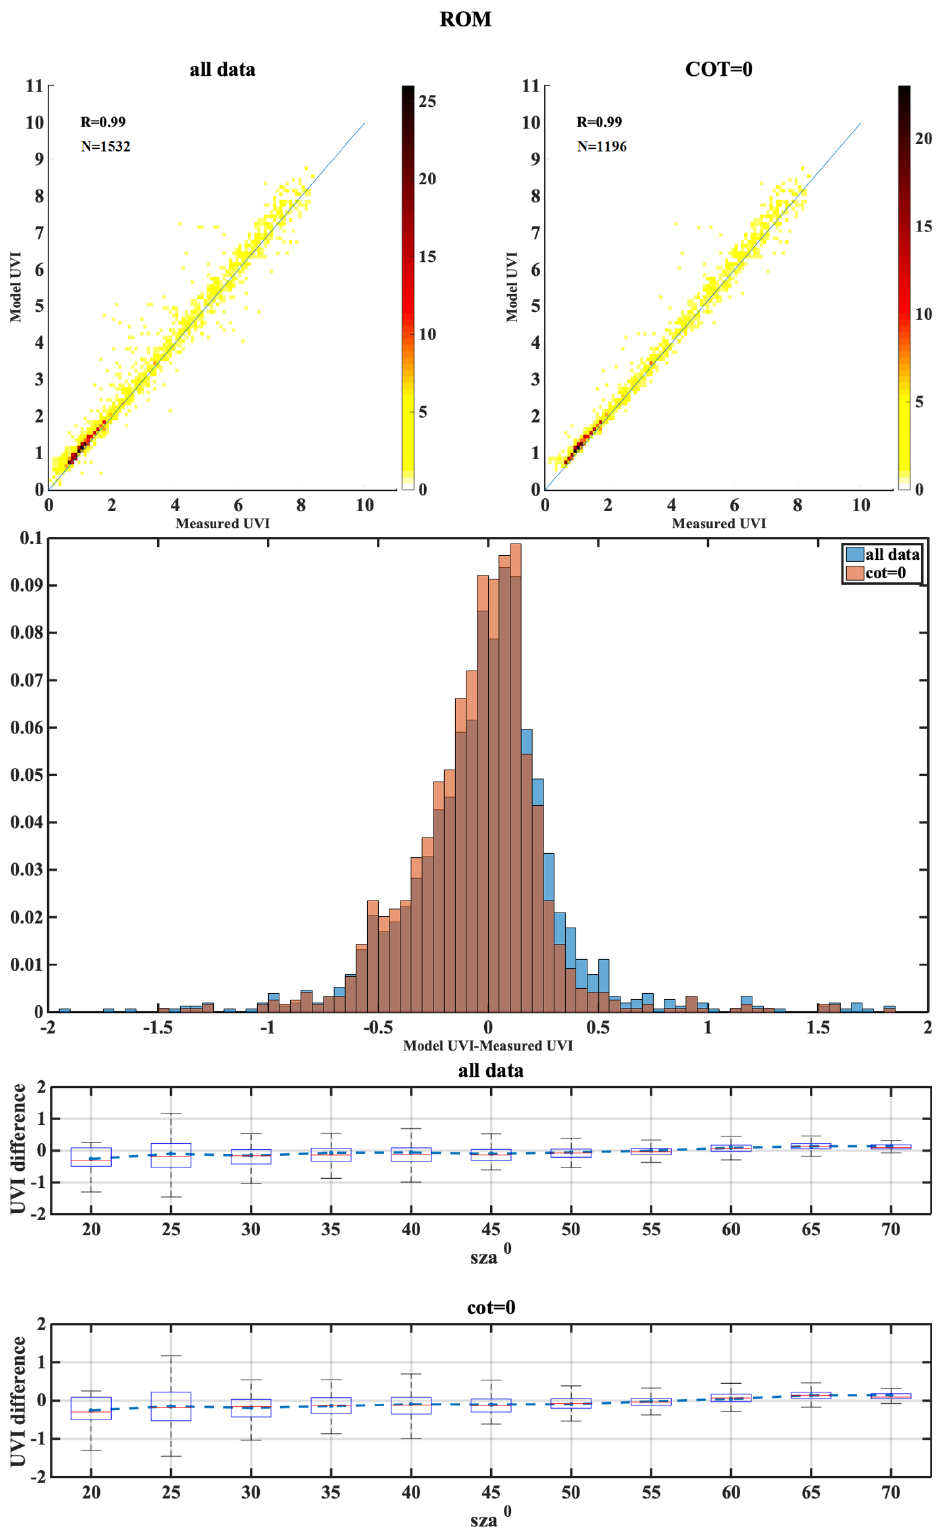
Figure A12. Same as above but for the ROM